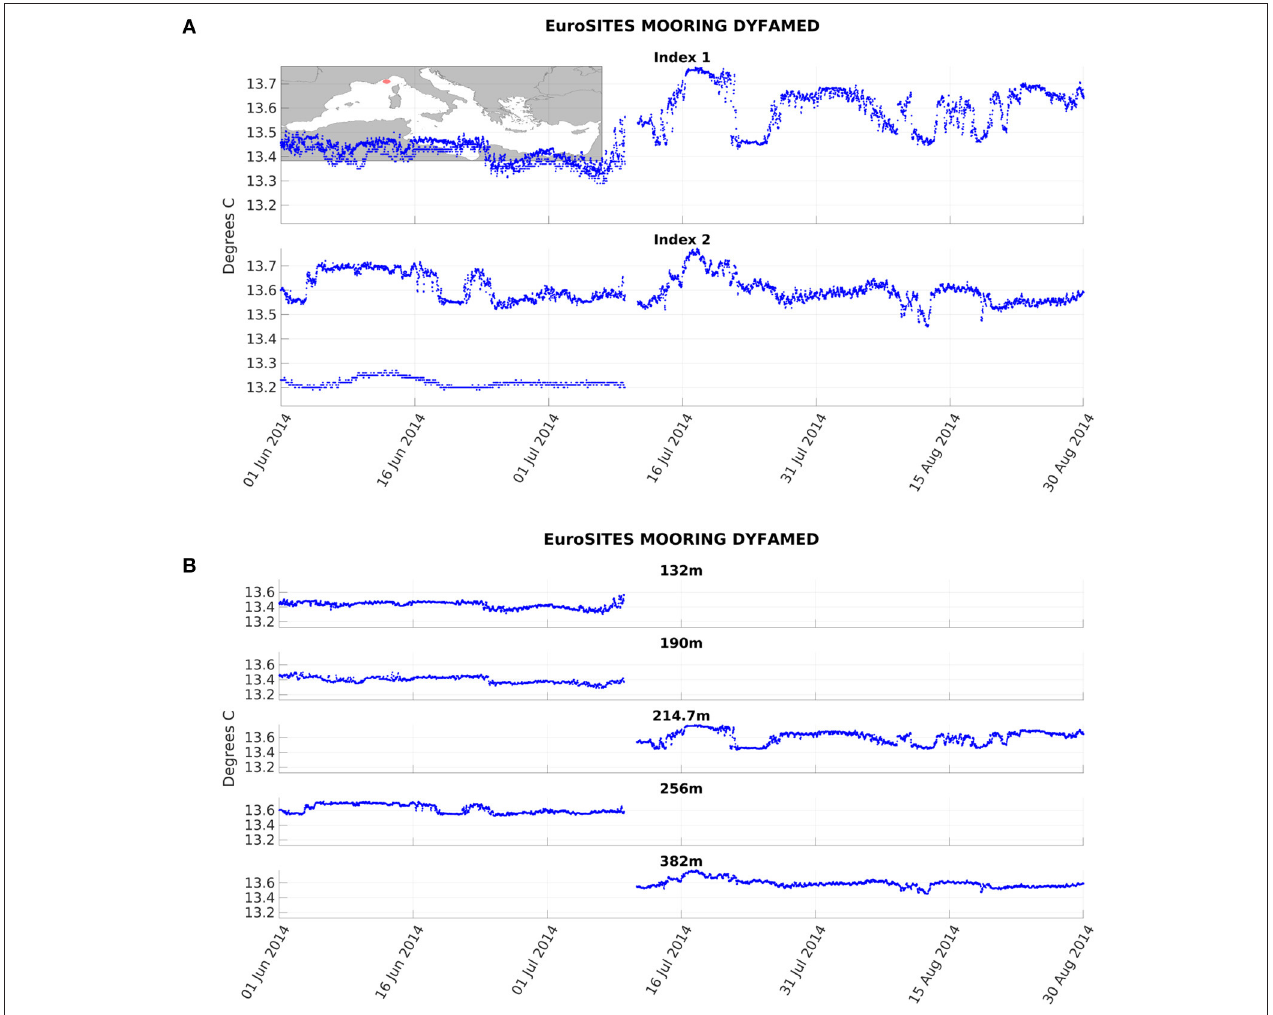
FIGURE 4 | Example of data depth aggregation at the DYFAMED mooring in 2014: (A) temperature data at index 1 and index 2; (B) temperature data at the corresponding depths.